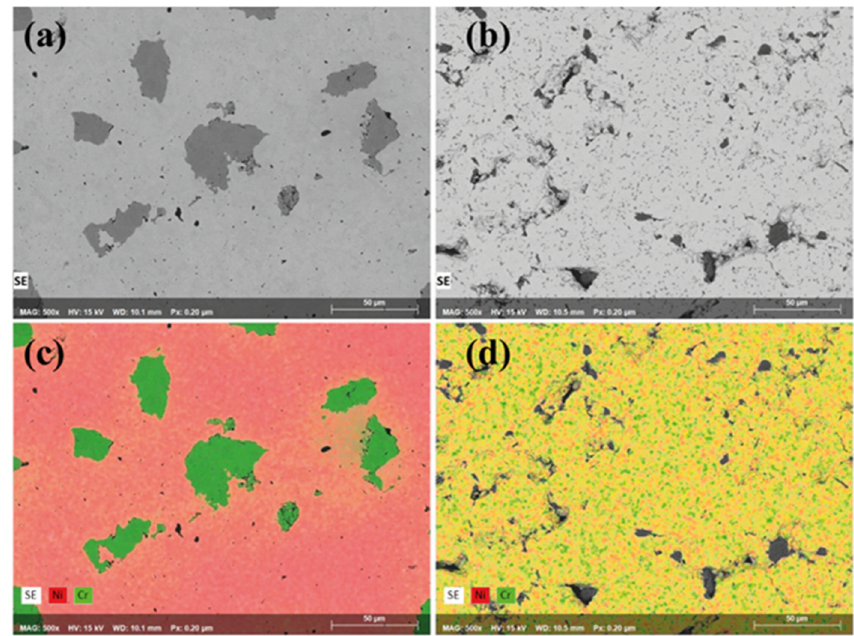
Figure 3. Scanning electron micrograph of ( a ) NiCr-m and ( b ) NiCr-p electrodes and the correspond- ing elemental mapping of the surface ( c , d ).